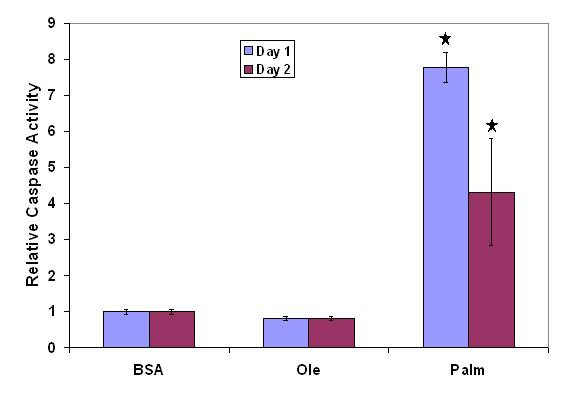
Caspase activity. Palmitate treatment increased caspase-3 activity significantly as compared to control (BSA) and unsaturated fatty acid (oleate). * significantly higher in palmitate, p < 0.01 by t-test. BSA: control, Ole: oleate treatment, Palm: palmitate treatment.